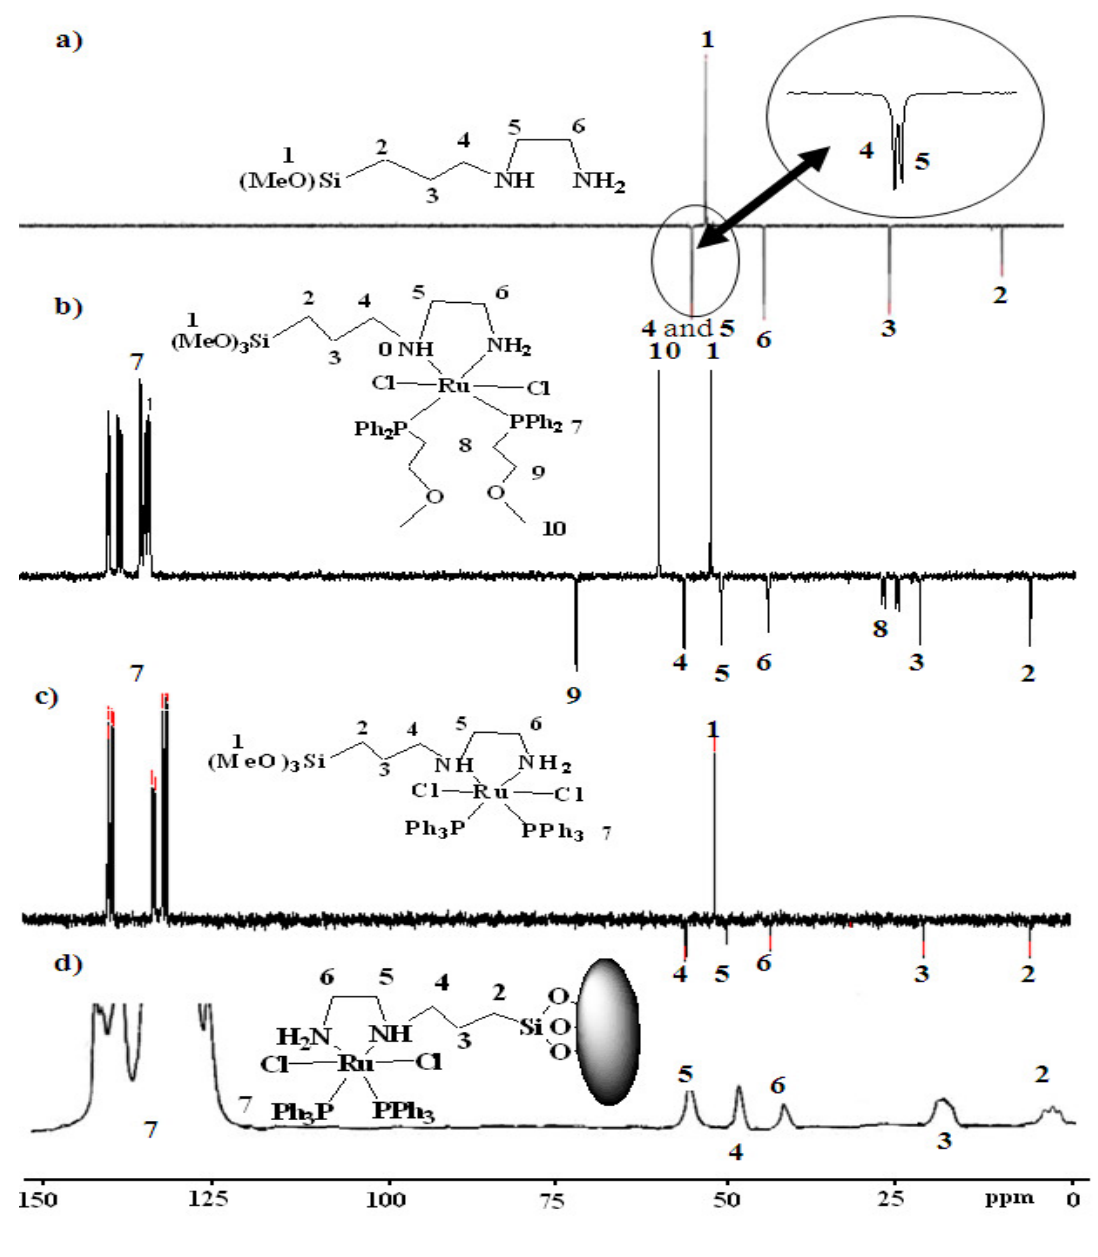
Figure 5. Dept 135 13 C-NMR of: a) free [3-(2-aminoethyl)aminopropyl]trimethoxysilane; b) complex 1 in CDCl ; c) complex 2 in CDCl ; compared by solid state 13 C-CP-MAS- 3 3 NMR; d) X2